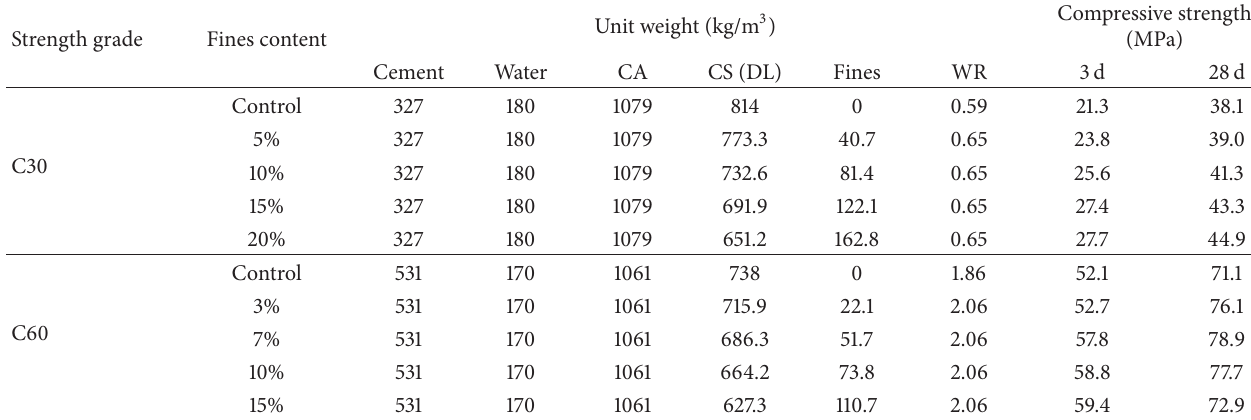
Table 3: Concrete mix proportions and strengths of resultant